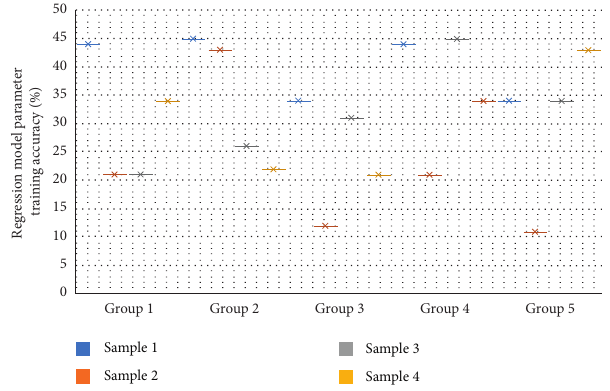
Figure 8: Regression model parameter training accuracy